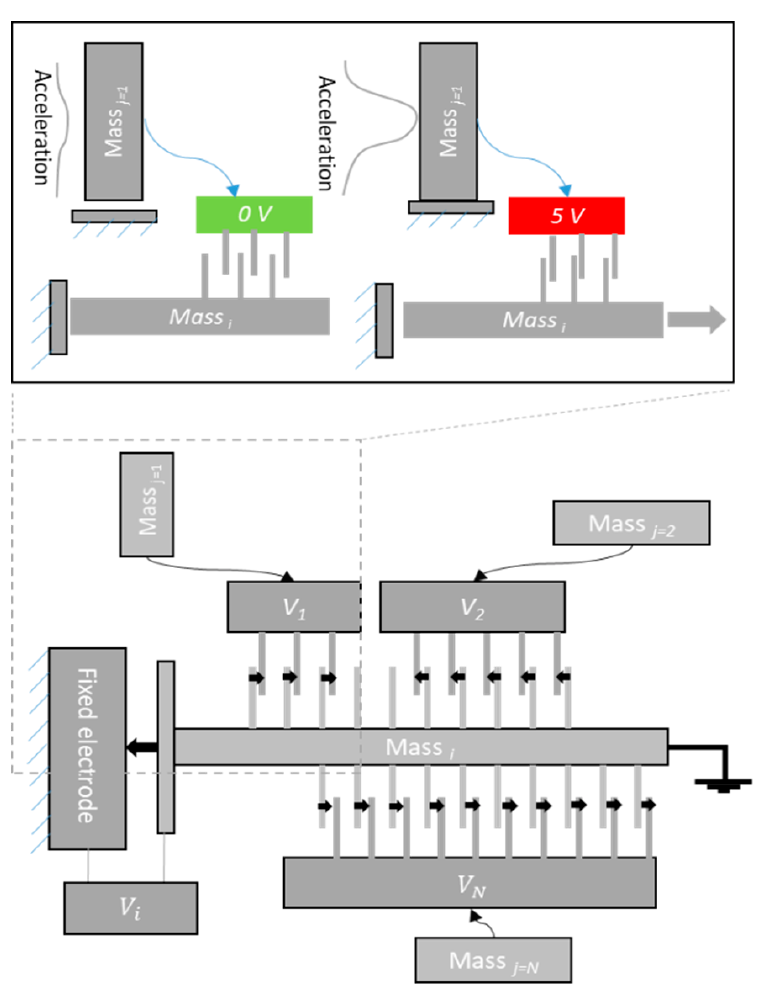
Figure 5. The finger arrays approach to realize electrostatic coupling between the MEMS CTRNs.